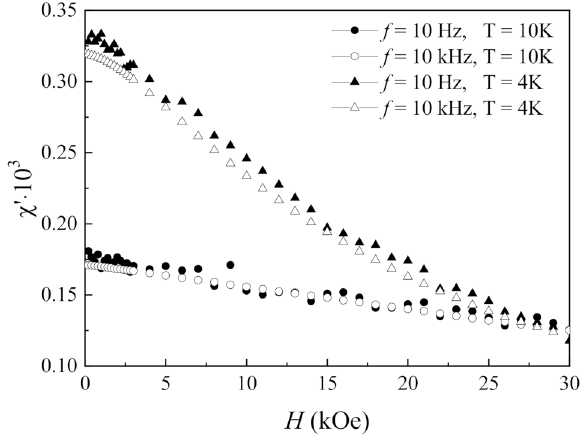
Figure 8. Magnetic field dependences of the real part of the AC susceptibility for the nanocomposite with the ytterbium